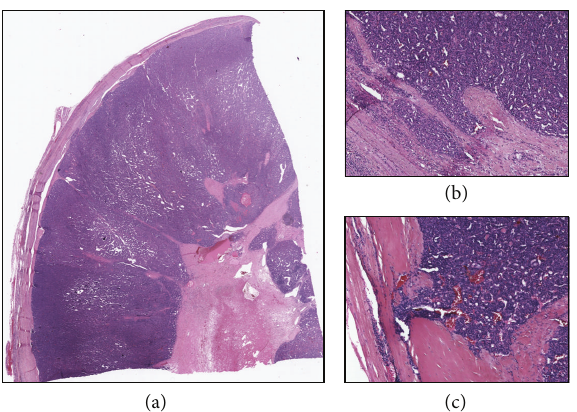
Figure 2: Representative images of a follicular carcinoma previously treated with RFA. (a) The lower magnification (0.8x) picture shows scattered areas of hyaline sclerosis and scarring due to RFA, which do not affect the capsule. (b-c) The higher magnification (4x and 10x, resp.) pictures show spots of capsular invasion.